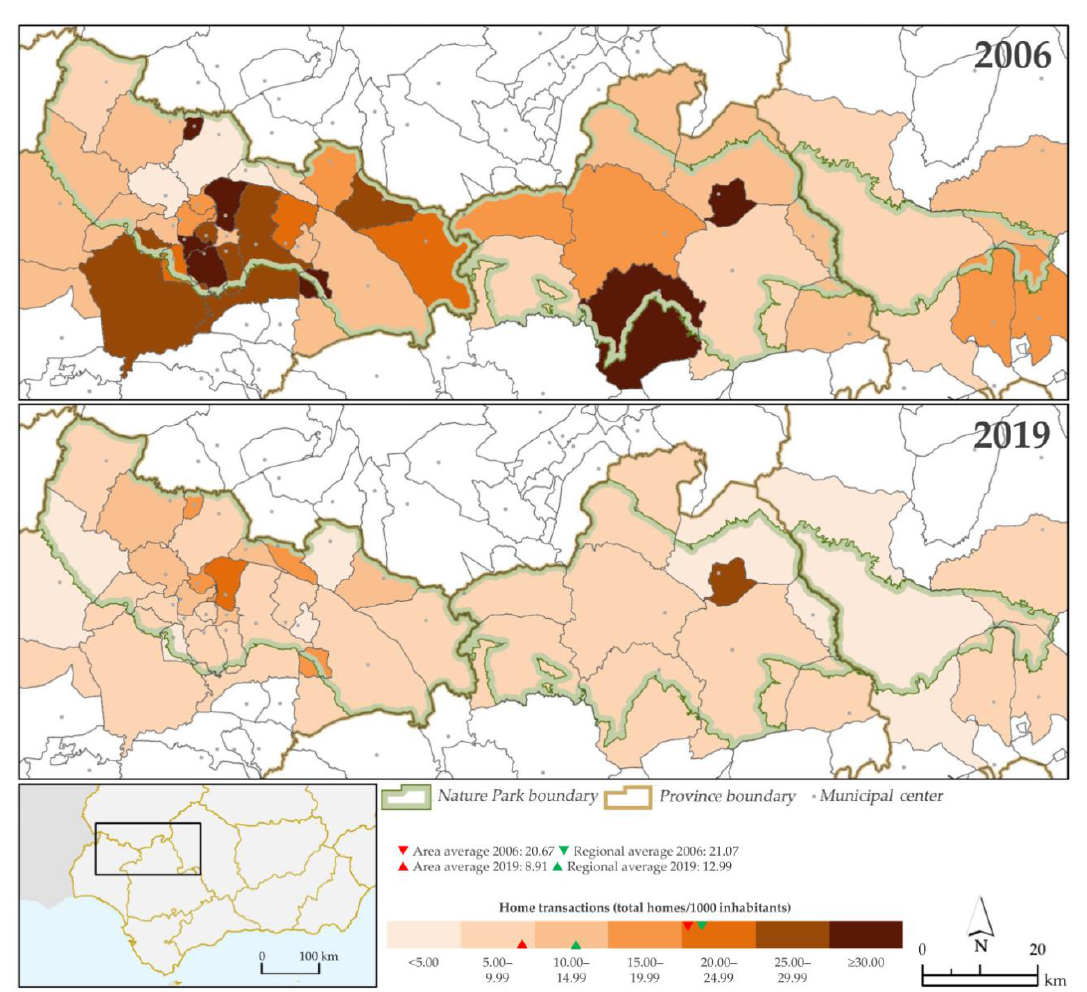
Figure 15. Real estate transactions in 2006 and 2019. Source: [85]; authors’ elaboration.